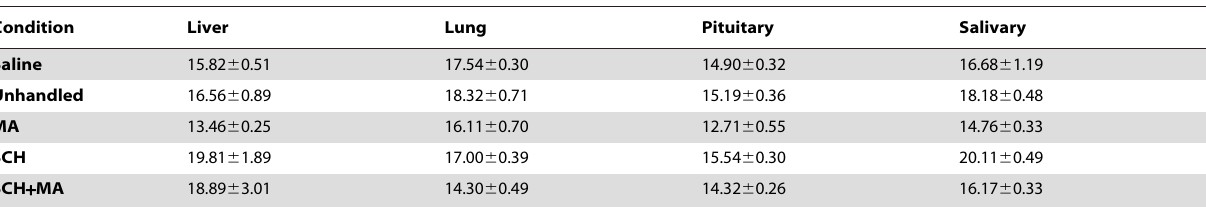
Mean 6 SEM (circulaer) peak PER2::LUC phase, presented in ZT (in h, where ZT0 is lights-on and ZT7 is the time g004of MA injection). Numbers of tissues scored are presented in Table S1. See Fig. 4 for graphical representation and statistics.